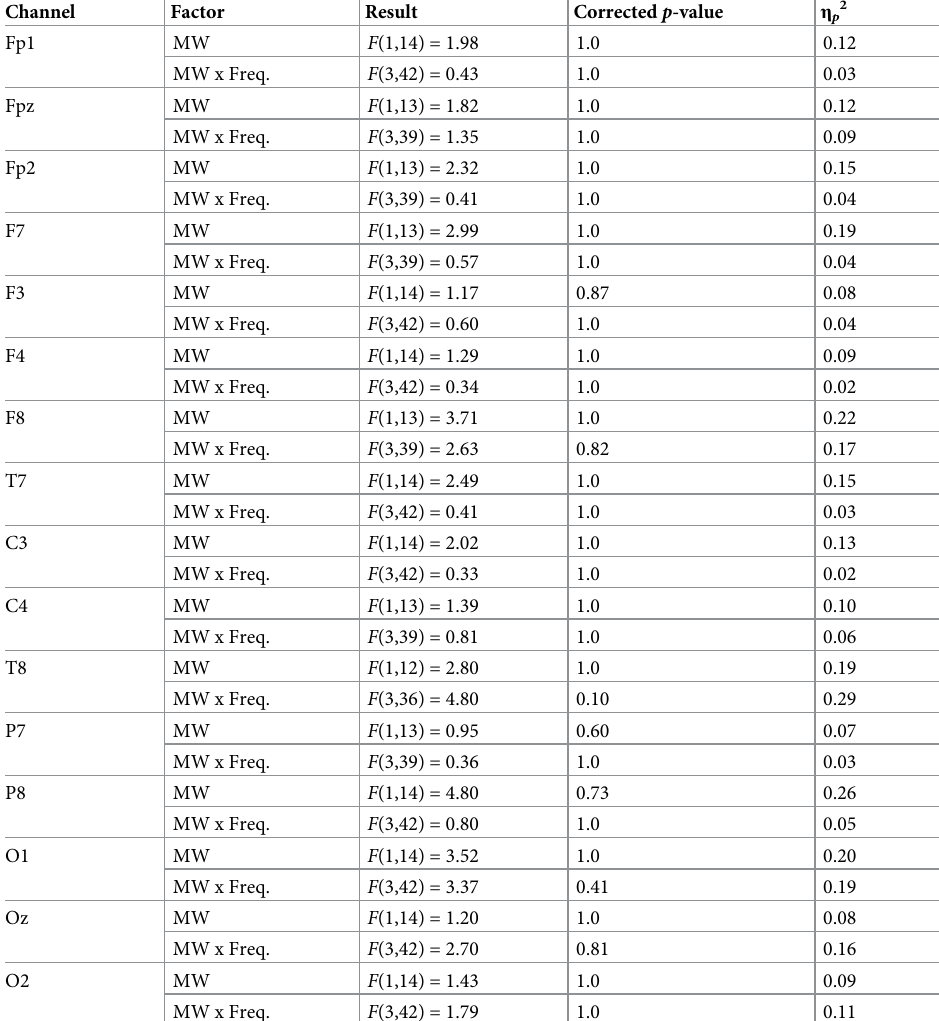
Table 4. Results of repeated-measures ANOVA models for each channel.